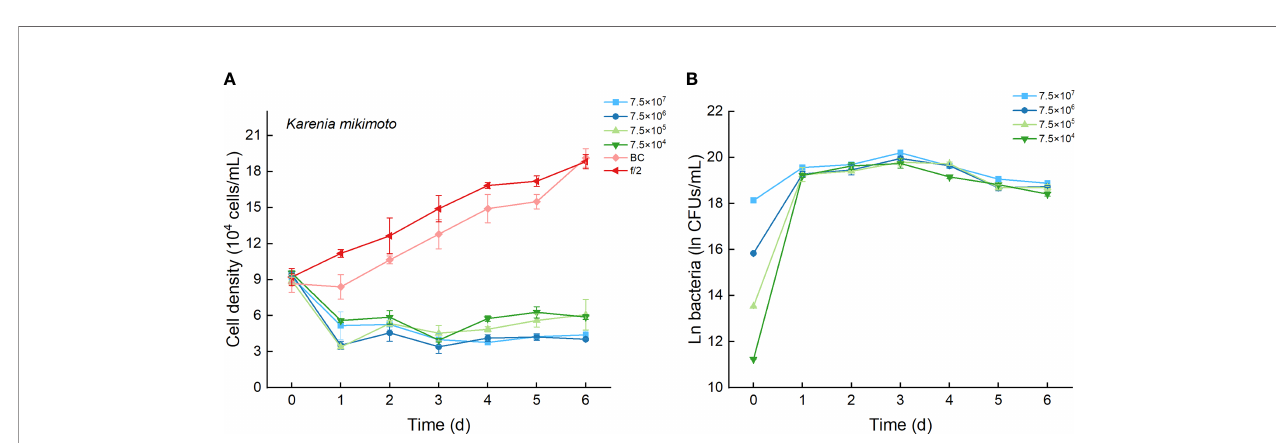
FIGURE 8 | The growth of Karenia mikimotoi in the co-cultures with different concentrations of bacterial strain Lf7 (7.5×10 4 -7.5×10 7 CFUs/mL). (A) Growth curves of K. mikimotoi in co-cultures with Lf7, (B) Lf7 concentration in the algal